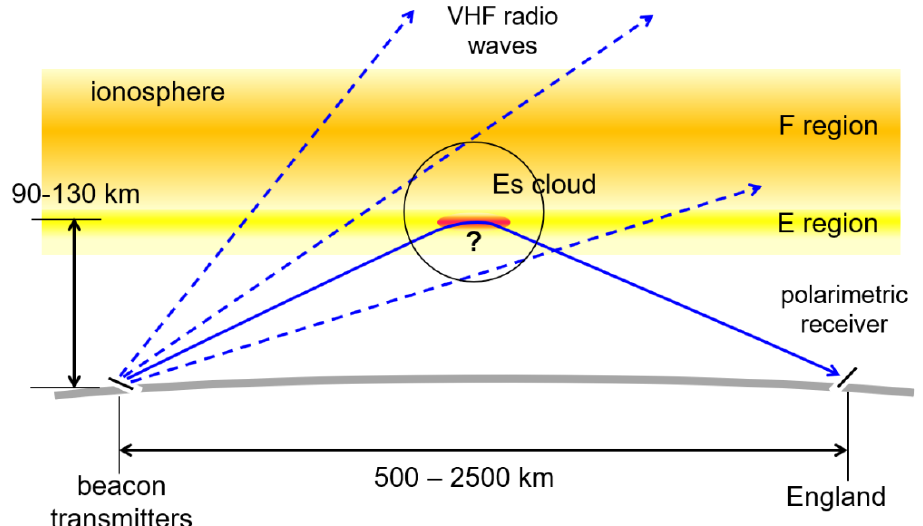
Figure 1. Reflection of VHF radio waves by sporadic-E (Es) clouds. © 2021 IEEE. Reprinted, with permission, from [21].